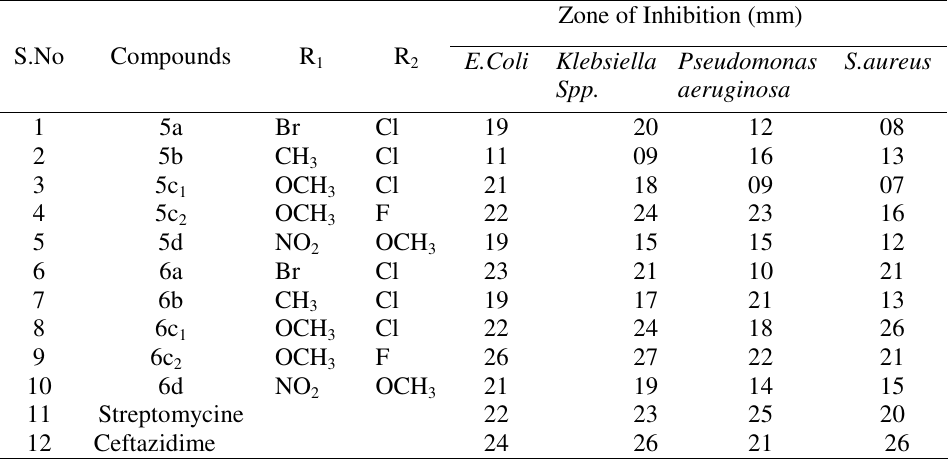
Table 2 . The zone of inhibition in mm of the compound as well as standard drugs tested for antibacterial activity.